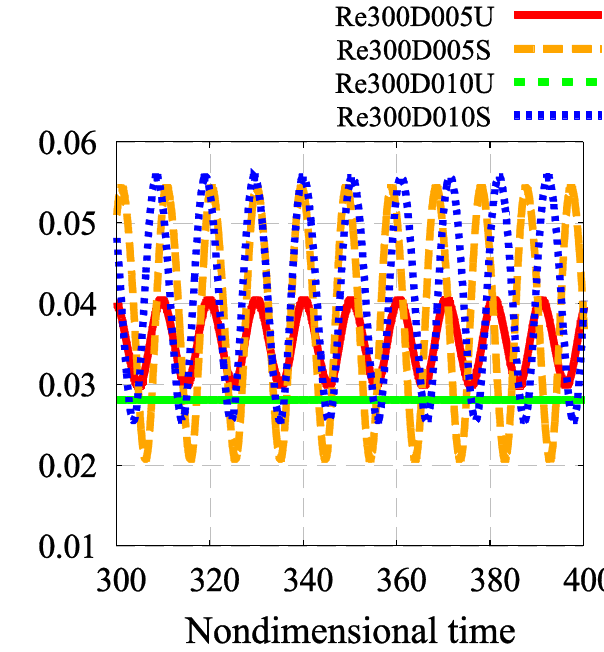
Figure 6. Variation of lift coefficient at Re = 300.